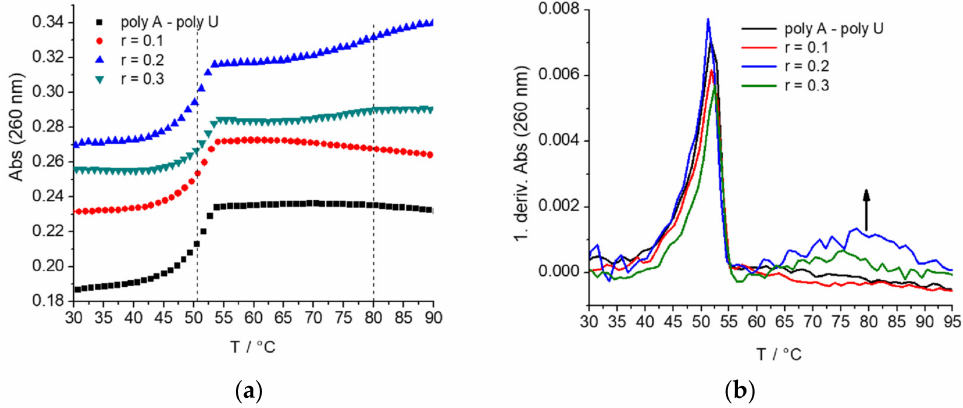
Figure 6. ( a ) Thermal denaturation of poly A—poly U ( c = 2.0 × 10 − 5 M), upon addition r = 0.1, r = 0.2, r = 0.3, ([compound/[polynucleotide]) of DAE-NH-Py (open form) at pH 7.0 (buffer sodium cacodylate, I = 0.05 M)/0.5% DMSO, ( b ) The 1. derivative of absorbance on temperature. Table 2. a ∆ T m -Values ( ◦ C) for different ratios b r of DAE-NH 2 and DAE-NH-Py added to the polynucleotide. Compound b r ct-DNA poly A—poly